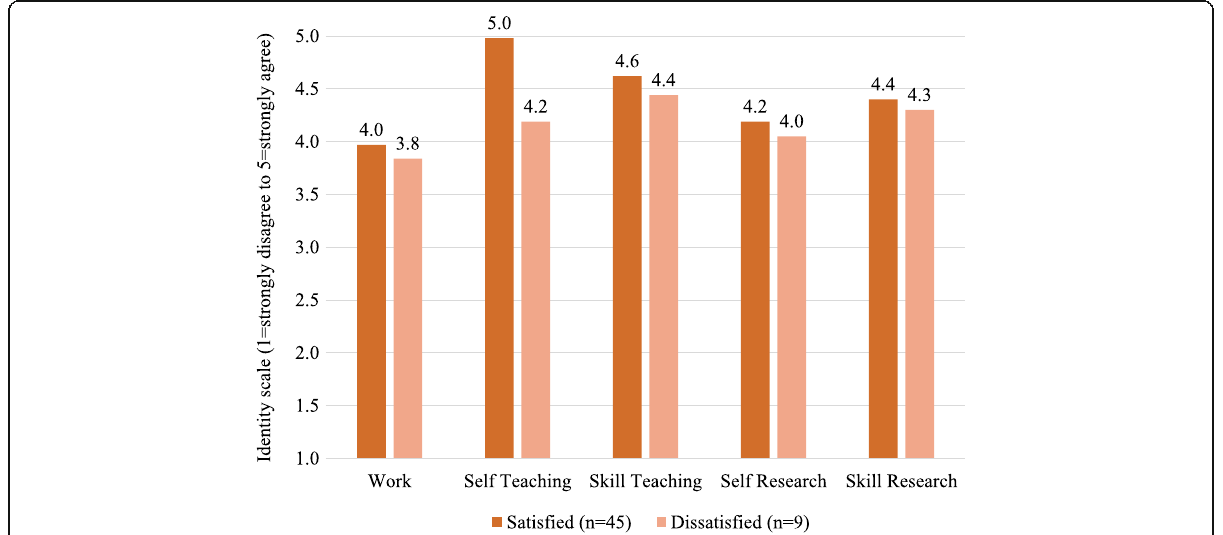
Fig. 4 Descriptive differences in professional identity dimensions for participants who were satisfied and dissatisfied with their use of collaborative learning